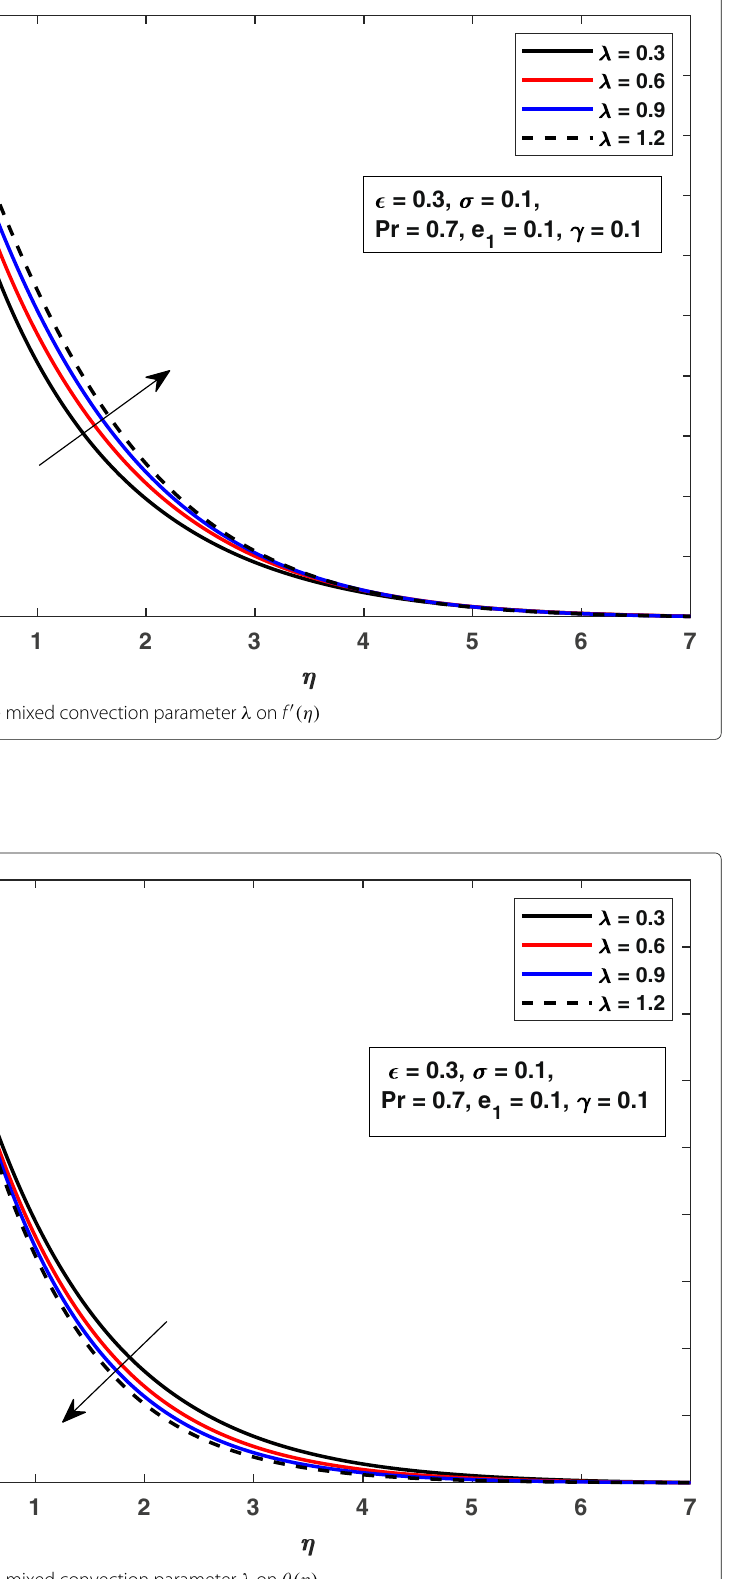
Fig. 7 Impact of the mixed convection parameter λ on